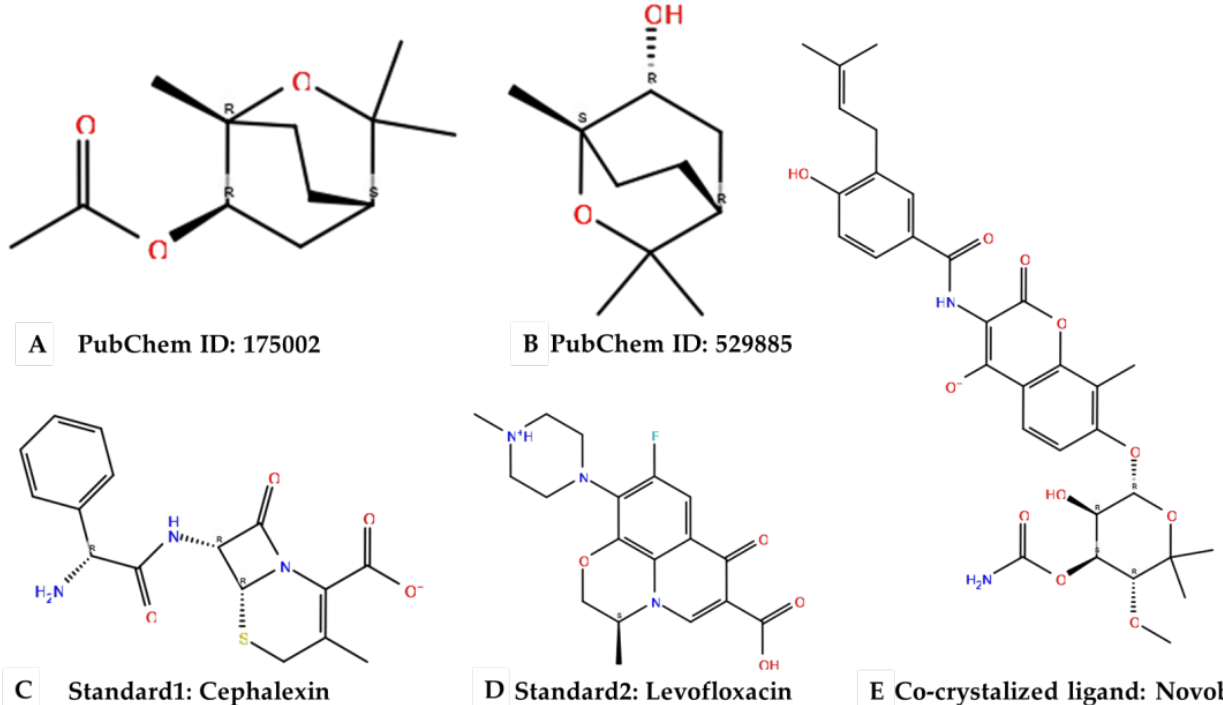
Figure 1. Chemical structures of the identified active molecules ( A , B ) with cephalexin ( C ) and levofloxacin ( D ) as standards and novobiocin ( E ) as a co-crystalized ligand were shown in Figure 1 above.